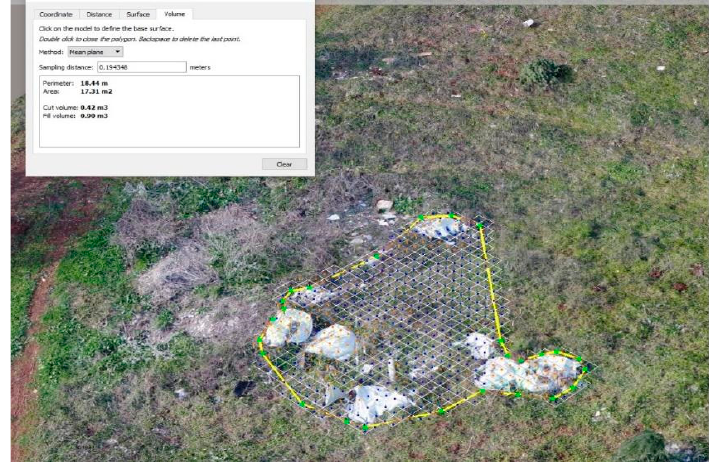
Figure 3. Orthophotos of illegal waste dumping sites. Site #2—plastic bags; area 17.31 m 2 , volume 0.42 m 3 . Sites #3 and #4 represent sites with mixed heterogeneous wastes. Site #3 is an example of concentrated waste, and site #4 is an example of a spread-out dump site.